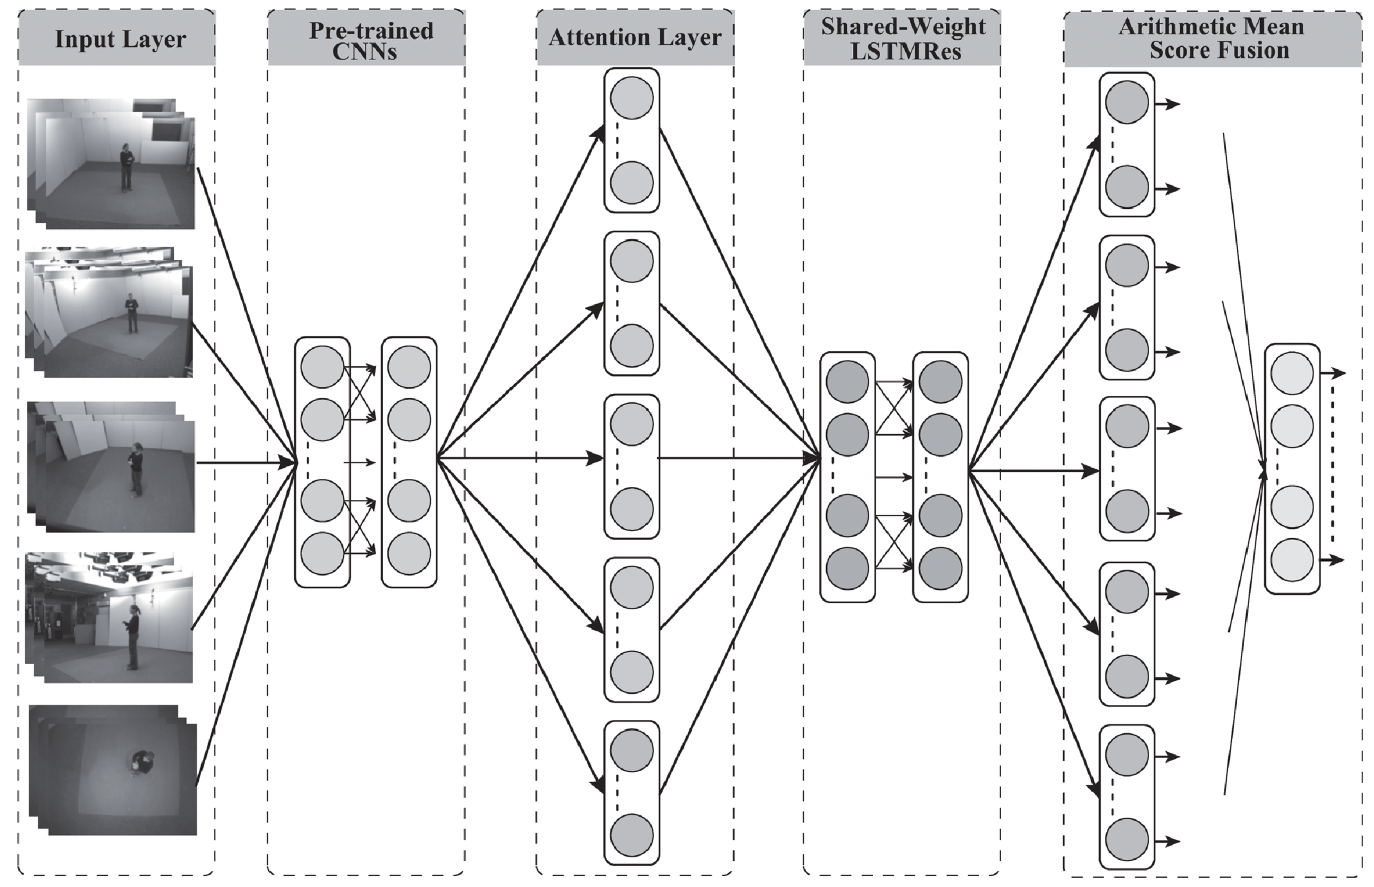
Fig 1. Architecture of the proposed model. Pre-trained CNNs and LSTMRes were shared across inputs.